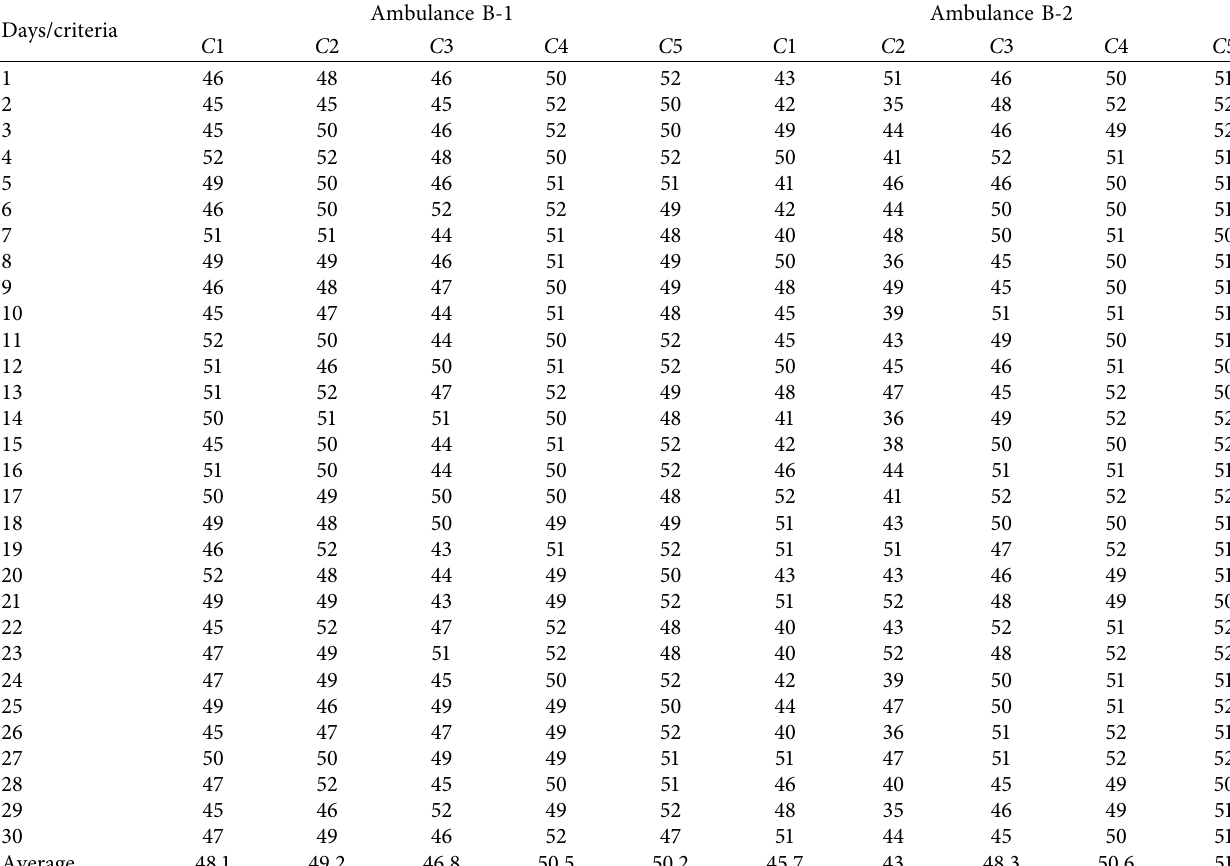
Table 5: Evaluation of daily missions in compliance with health protocols in the emergency center B.